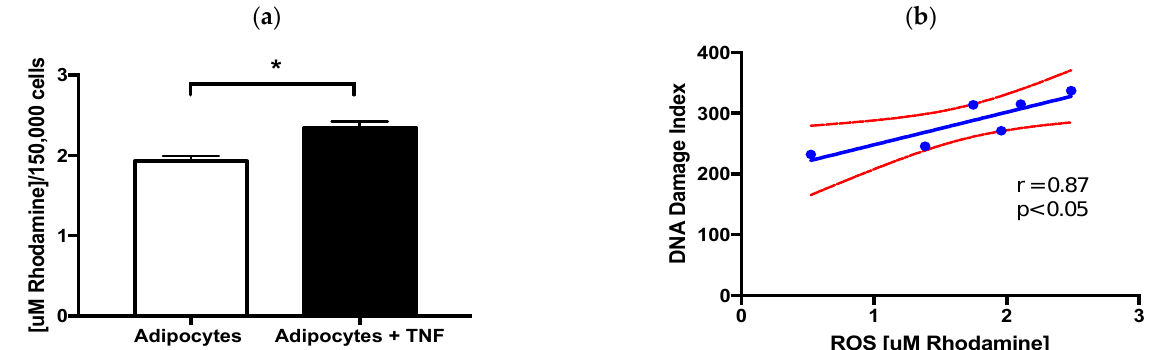
Figure 3. ROS and DNA damage. ( a ) Intracellular ROS levels induced by TNF α treatment (24 h, 125 ng/mL) in newly differentiated adipocytes, three independent experiments with experimental replicate were carried out. Student’s t test * p < 0.05. ( b ) Positive relationship between intracellular ROS levels and DNA damage index induced by TNF α . Pearson ´ s correlation, coefficient of correlation r = 0.87 and * p <